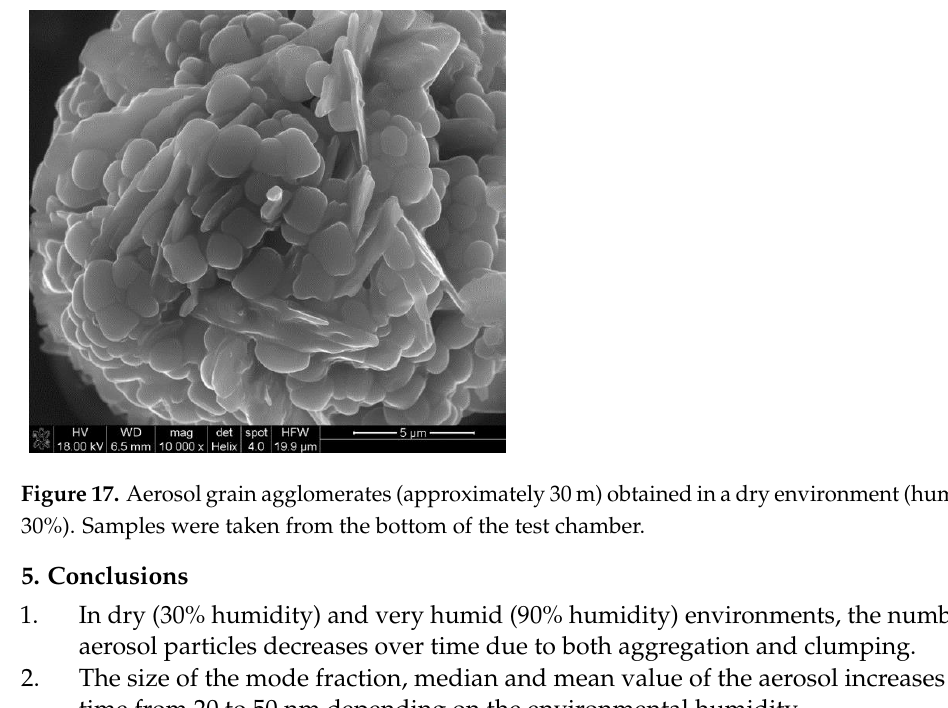
Figure 16. Smaller grain agglomerates and individual nanoparticles in a moist environment (hu- midity 70%). Samples were collected from the bottom of the test chamber.